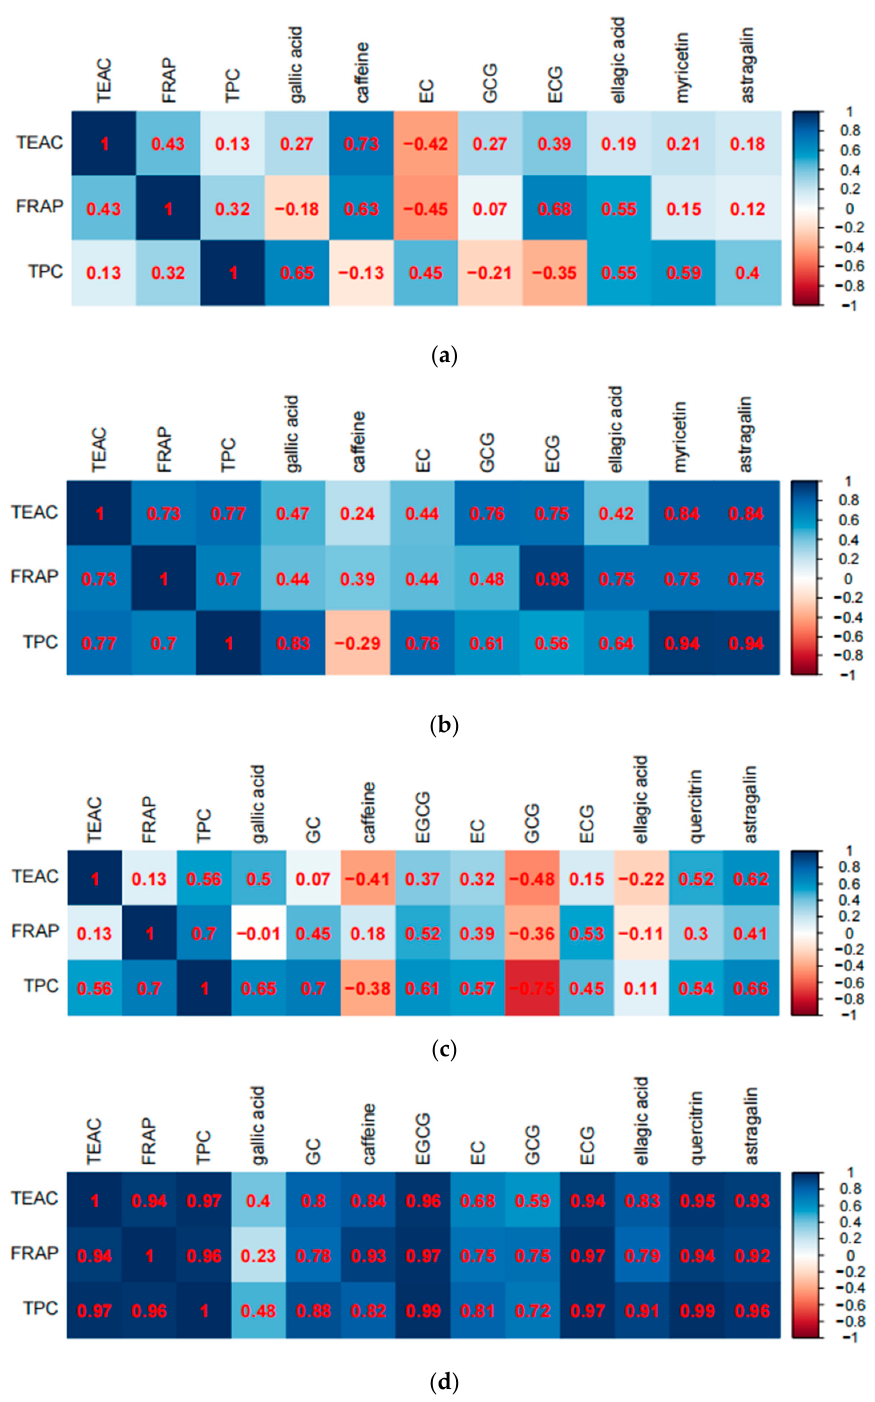
Figure 7. Heat maps analysis of the correlations between parameters and compounds. ( a ) kombucha from black tea without tea residue, ( b ) kombucha from black tea with tea residue, and ( c ) kombucha from green tea without residue, and ( d ) kombucha from green tea with tea residue.